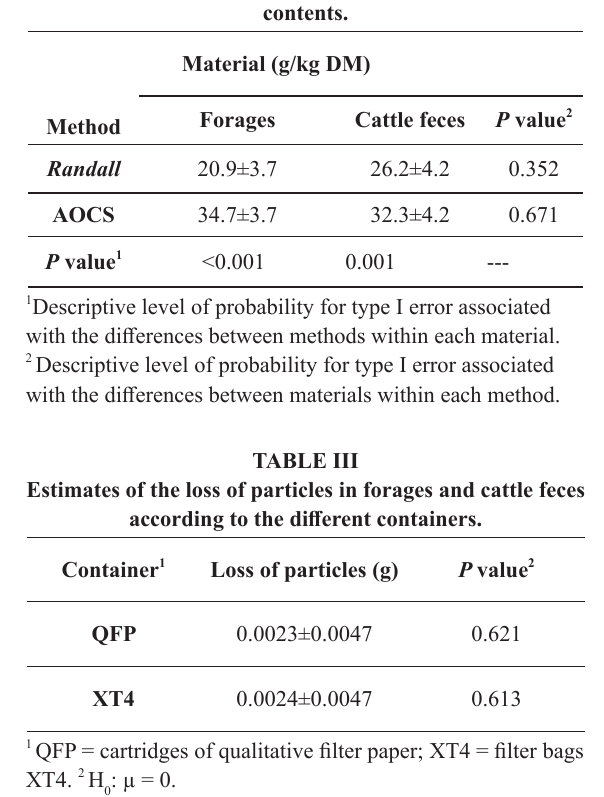
Evaluation of the interaction between method of extraction and evaluated material on ether extract